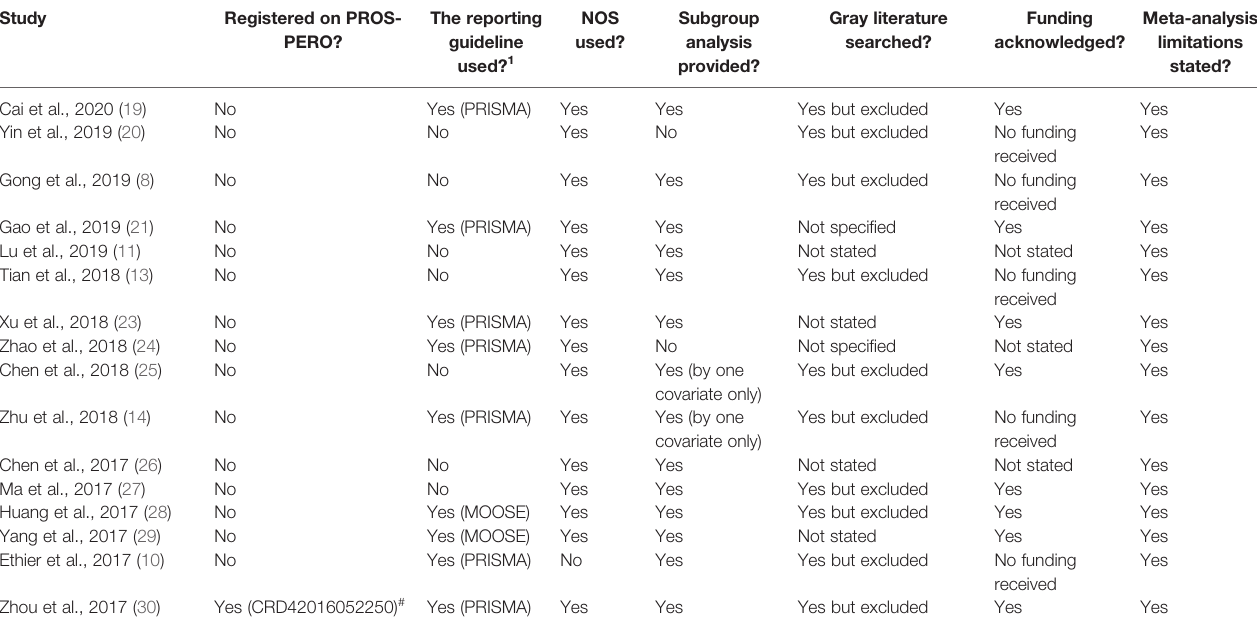
TABLE 3 | Qualitative assessment of appraised systematic reviews and meta-analyses.